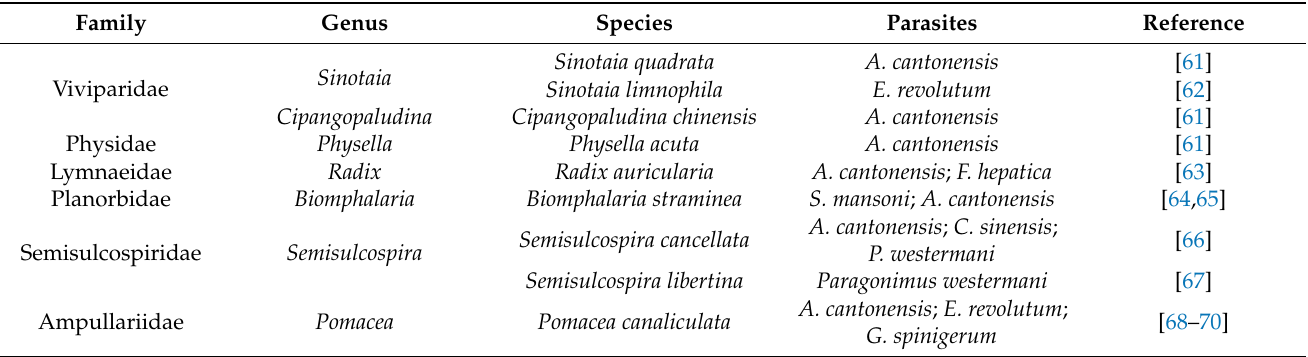
Table 2. Freshwater gastropod species found in the study area that can transmit parasitic diseases and the parasites they can